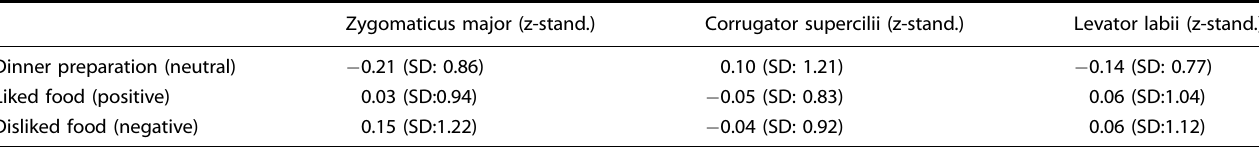
Table 3. Mean standardized activity of each muscle in each conversation